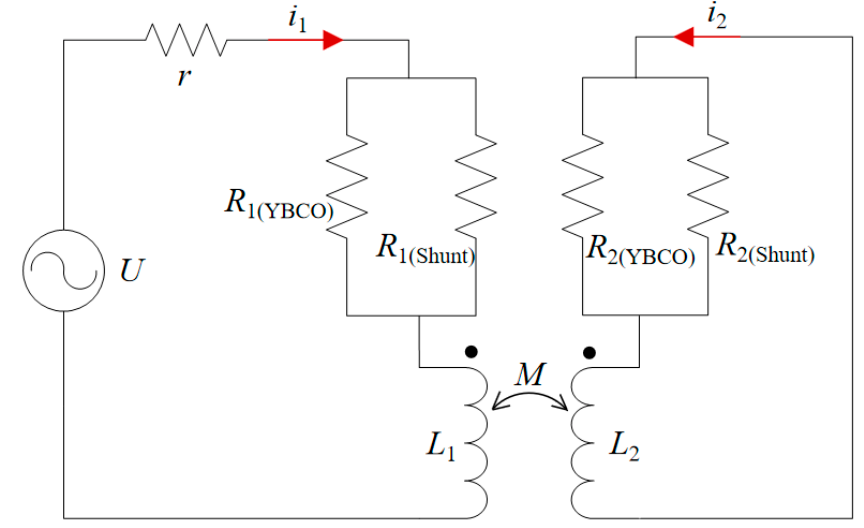
Figure 2. Schematic diagram of circuit model.